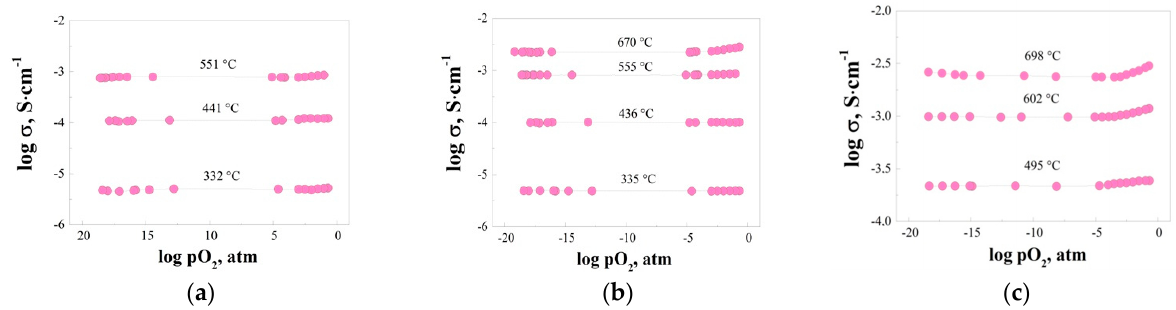
Figure 8. Dependence of the electrical conductivity of the composition on the oxygen partial pressure for ( a ) 0.95Gd 2 Zr 2 O 7 -0.05MgO, ( b ) 0.93Gd 2 Zr 2 O 7 -0.07MgO, ( c ) 0.90Gd 2 Zr 2 O 7 -0.10MgO.